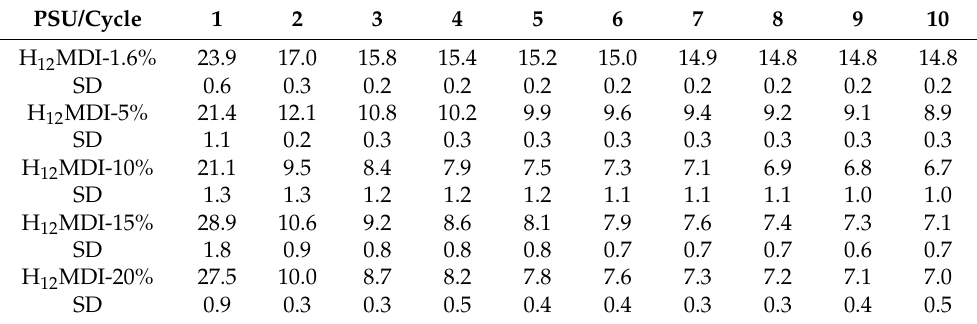
Table A5. Tensile hysteresis at 300% strain of PDMS-based polyurea elastomers synthesized from 4,4-methylenebis(cyclohexyl isocyanate) (H 12 MDI) with HS contents between 1.6% and 20%. Values are given as an average of three repeated measurements. SD: standard deviation.